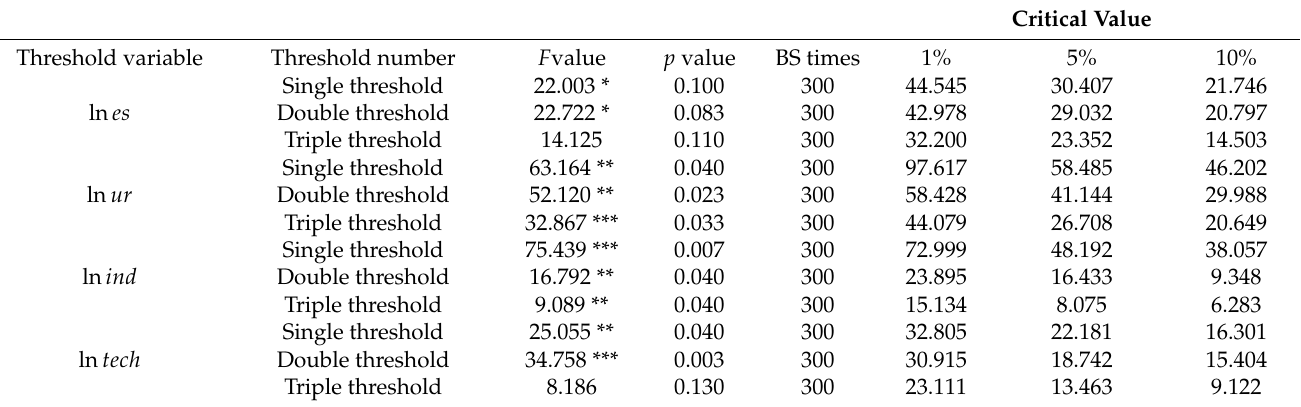
Table 5. Test results of threshold